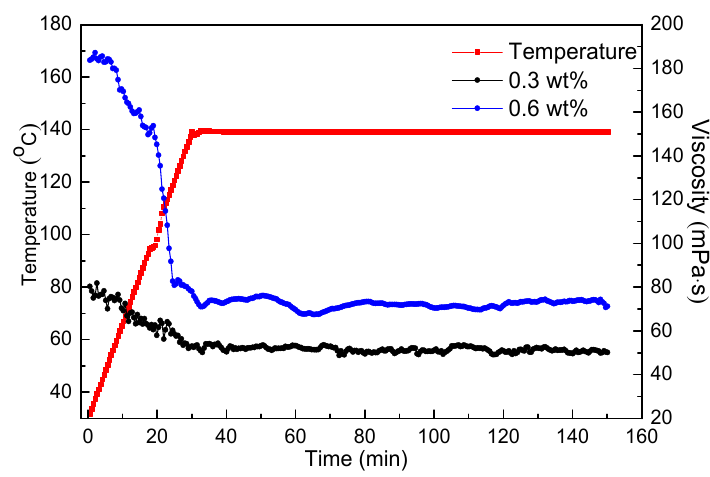
Figure 19. Rheological properties of 0.3 wt% and 0.6 wt% DiPHAM aqueous solutions at 140 °C.